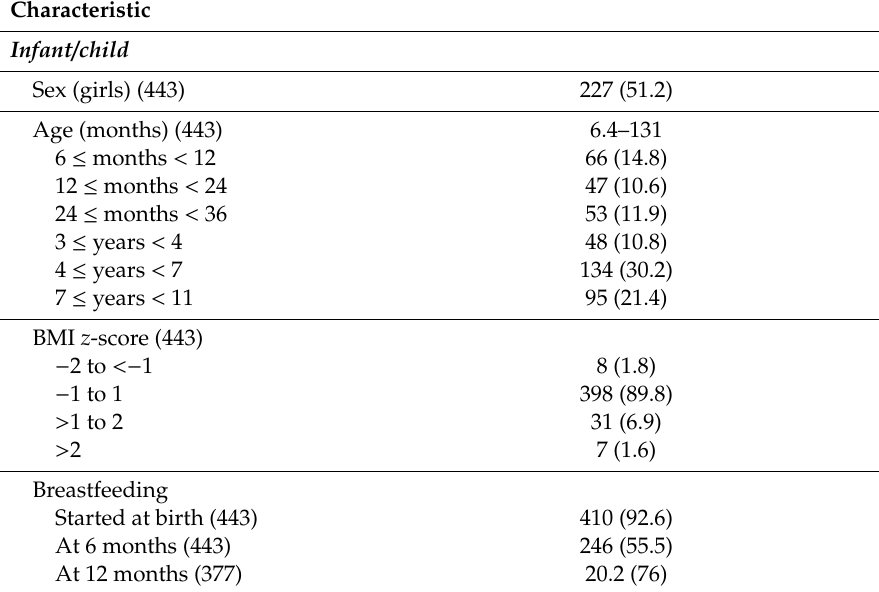
Table 2. Descriptive characteristics of participating children and their parents at recruitment ( n = 443). Number of valid observations within round